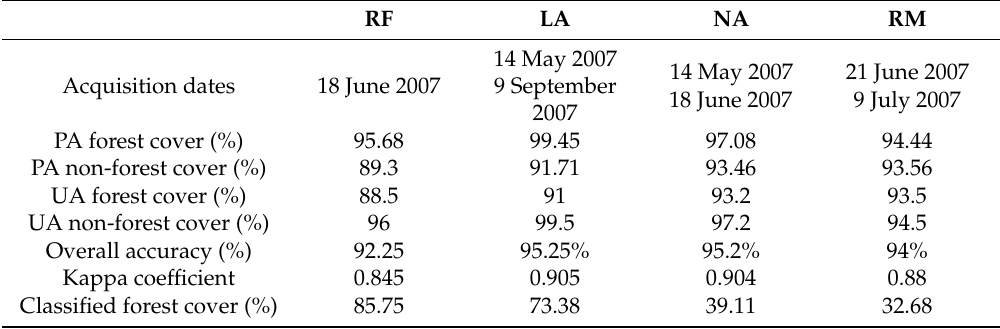
Table 2. Italian Agency for payments in agriculture (AGEA) orthophoto acquisition dates, accuracy assessment metrics of forest/non-forest cover maps, and percentage of forest cover within fire